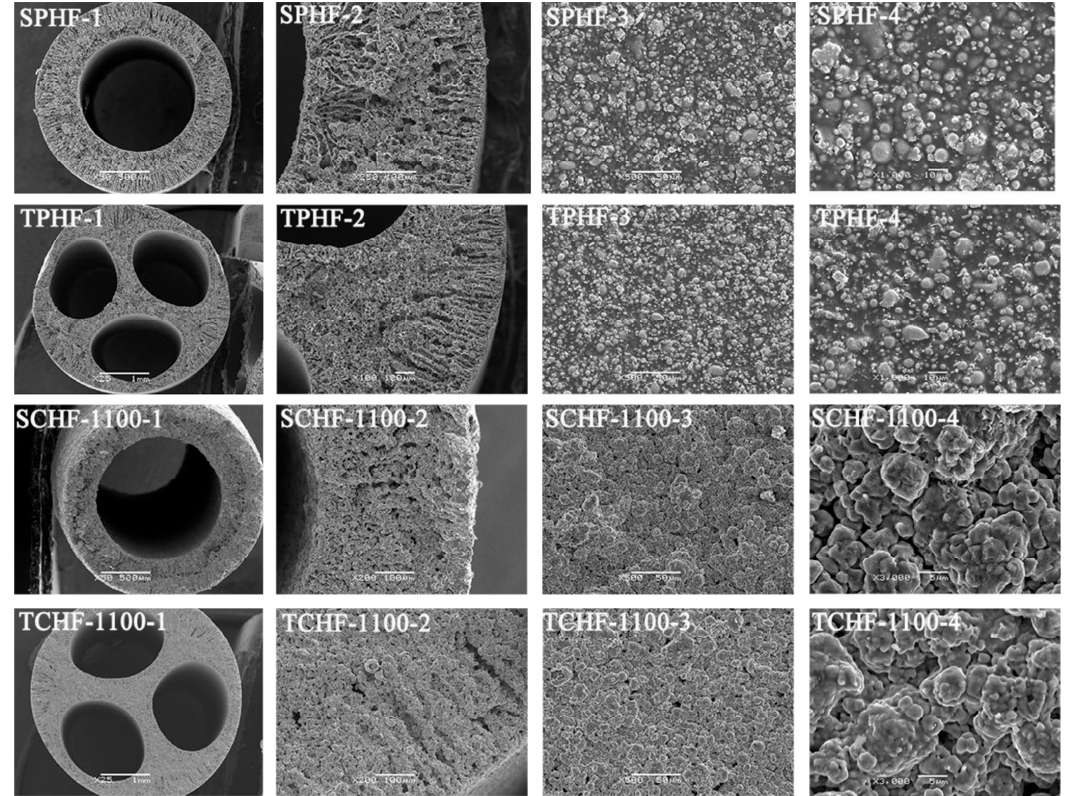
Figure 2. SEM images of the single-channel precursor hollow fibres (SPHF), three-channel precursor hollow fibres (TPHF), single-channel hollow fibres (SCHF), and three-channel hollow fibres (TCHF). 1, full views; 2, enlarged cross-sections (200×); 3, outer surfaces (500×); 4, outer surfaces (1000 and 3000×). Reprinted from “Fabrication, characterization and separation properties of three-channel stainless steel hollow fiber membrane” [83], © 2016, with permission from Elsevier.